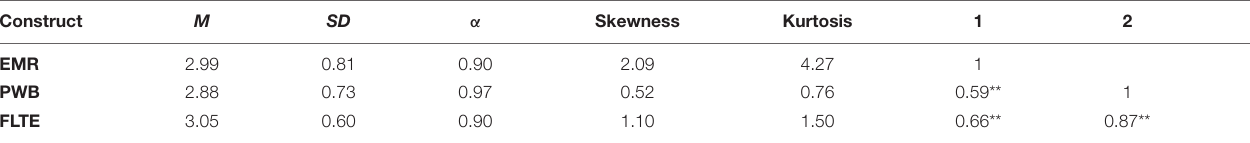
TABLE 2 | Descriptive statistics, reliability, and correlations between analyzed variables. Construct M SD